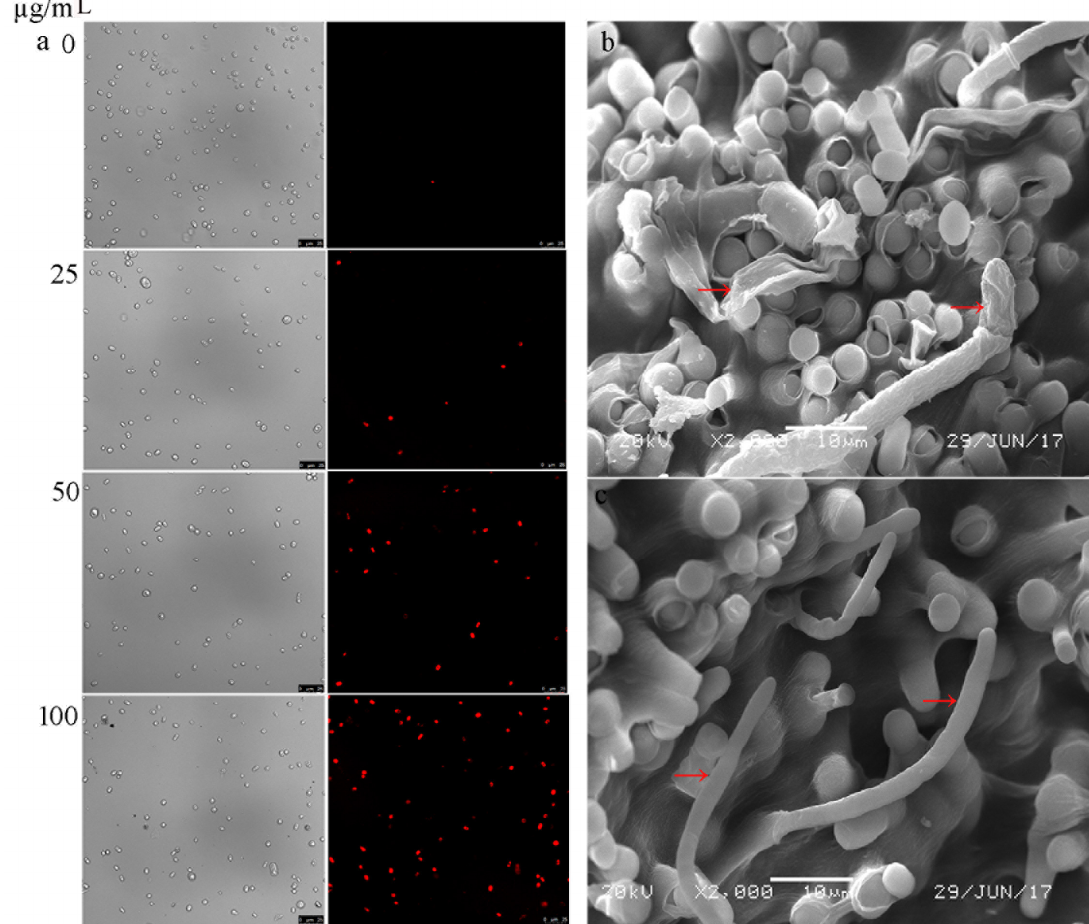
Figure 4. Plasma membranes of the spores that were damaged by cytosporone B represented by red fluorescence ( a ); scanning electron microscopy of hypha and spores of G. citri-aurantii underlying the treatment of cytosporone B ( b ); and negative control ( c